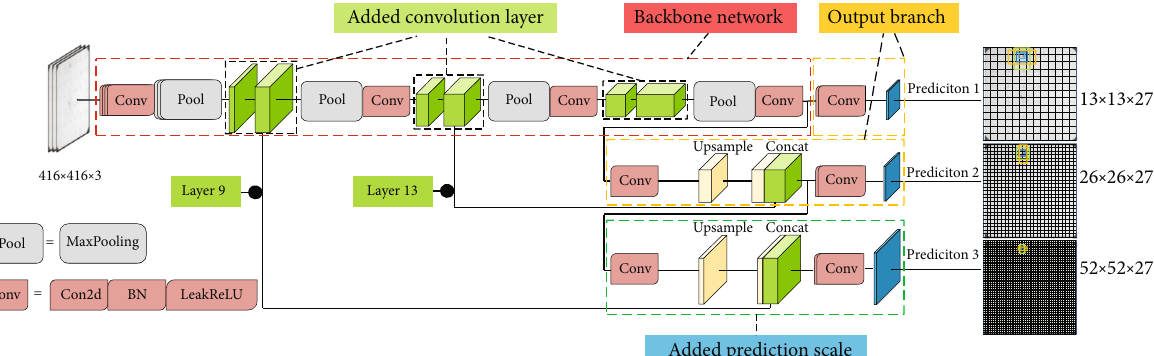
Figure 10: Improved single-cell defect detection network